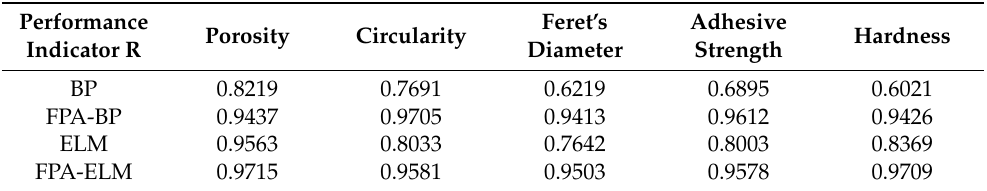
Table 1. The R prediction comparison results of the five parameters of the BP, FPA-BP, ELM and FPA-ELM model.